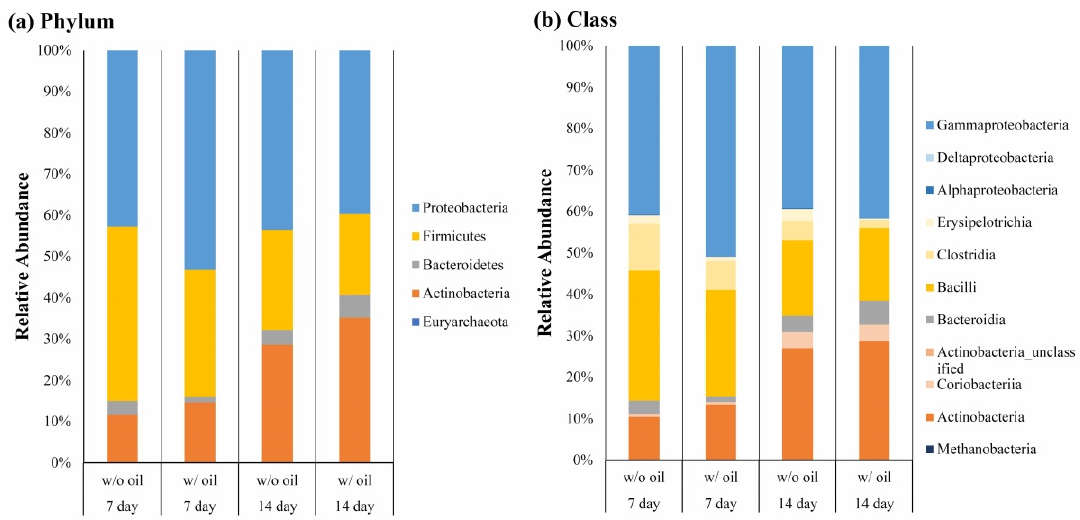
Figure 5. Relative abundance of bacteria in ( a ) phylum and ( b ) class levels on Day 7 and Day 14, when the tested teeth were treated with and without SM oil.